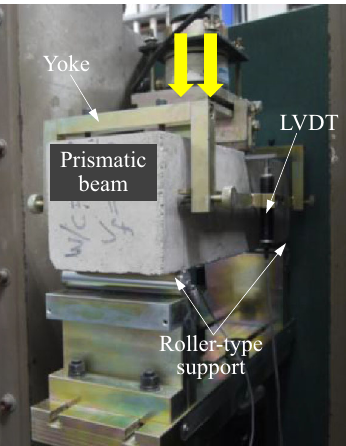
Fig. 4 Three-point flexural test for notched beam (RILEM TC